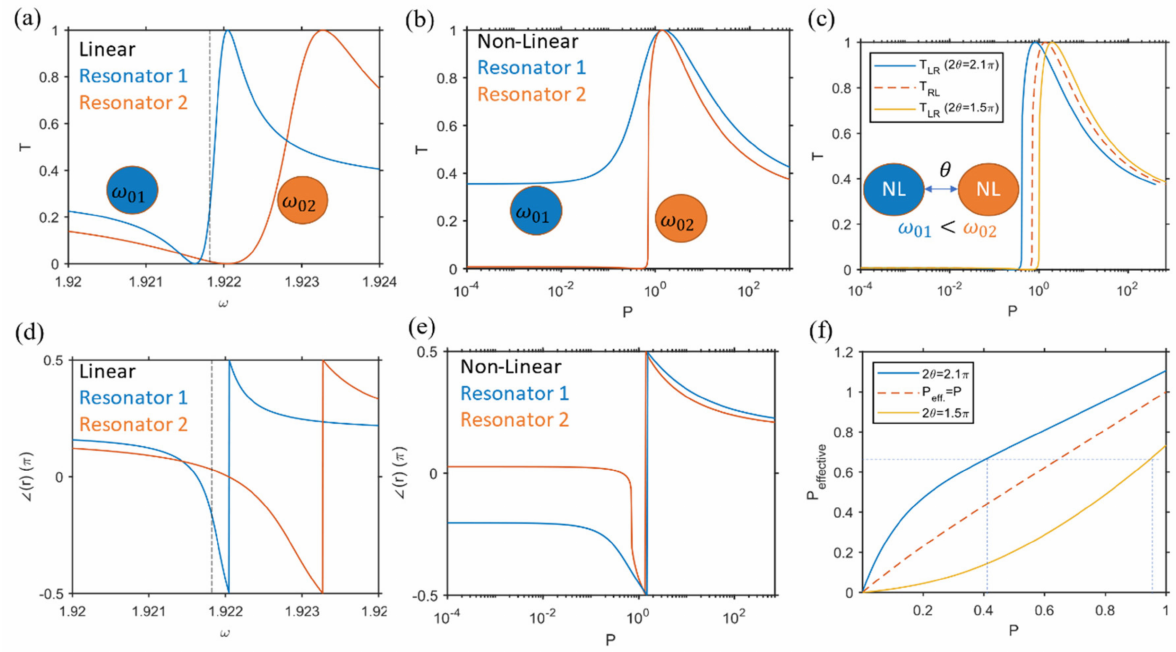
Figure 3. Operation of the device based on coupled shifted Fano resonators. ( a ) Linear transmission coefficient for two individual resonators with different zero transmission frequencies. ω 01 is the zero-transmission frequency of the first resonator, and ω 02 is for the second resonator. ( b ) Nonlinear transmission coefficient of the resonators in ( a ) excited at the frequency dictated by dashed lines in ( a ) with increased power P . ( c ) Nonlinear transmission coefficient for coupled resonators, separated by a delay line θ with increasing P . The transmission from left to right is T LR , while that from righ to left is denoted as T LR . ( d , e ) Linear and nonlinear reflection phases of the individual resonators. ( f ) The effective power seen by the second resonator when the device is excited from left for different electrical lengths θ . The vertical dashed lines indicate the required input power for the transition to happen in the transmission curve for the corresponding thetas. We used the parameters for resonator 1 and resonator 2 as given in Table 3 (row 1 and row 2) in Section 5.5 (Fano Resonator